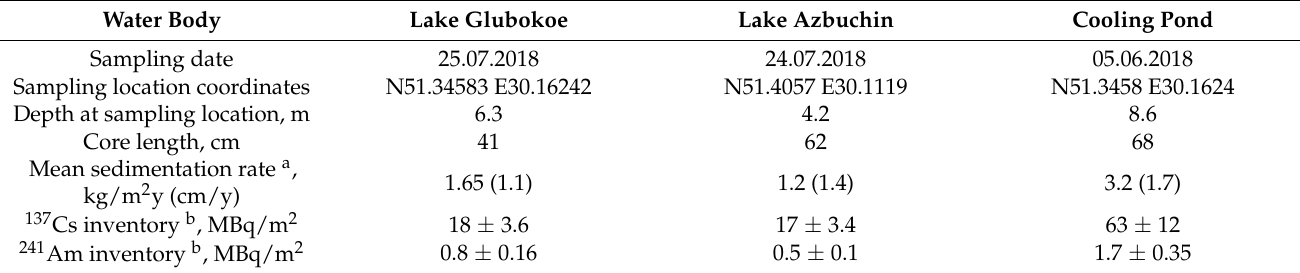
Table 2. Characterization of the bottom sediment